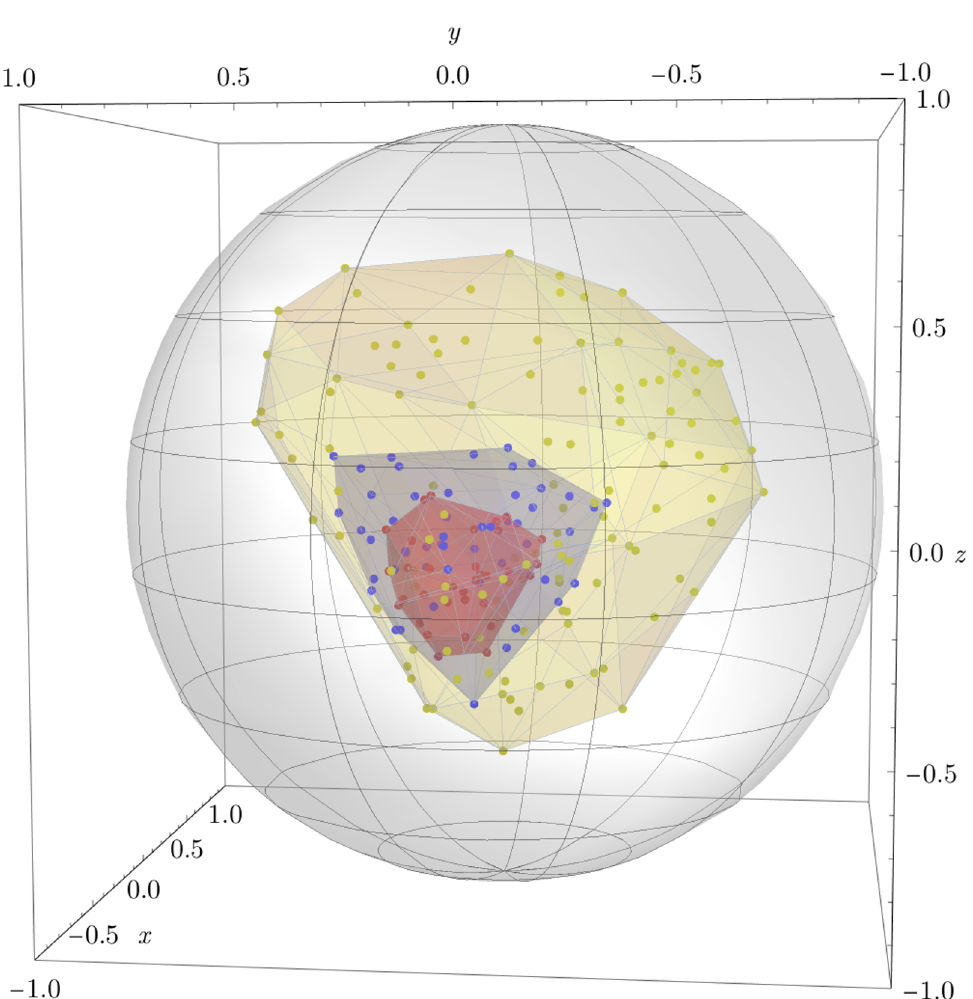
Figure 4 . Allowed points in external scalar OPE coe(cid:14)cient space, found while computing the allowed island in dimension space, for (cid:3) = 27 (yellow), (cid:3) = 35 (blue), and (cid:3) = 43 (red), together with a choice of bounding ellipsoid (gray). For each set of points, we also show their convex hull in the same color. To plot the points, we applied an a(cid:14)ne transformation to make the (cid:3) = 27 region roughly